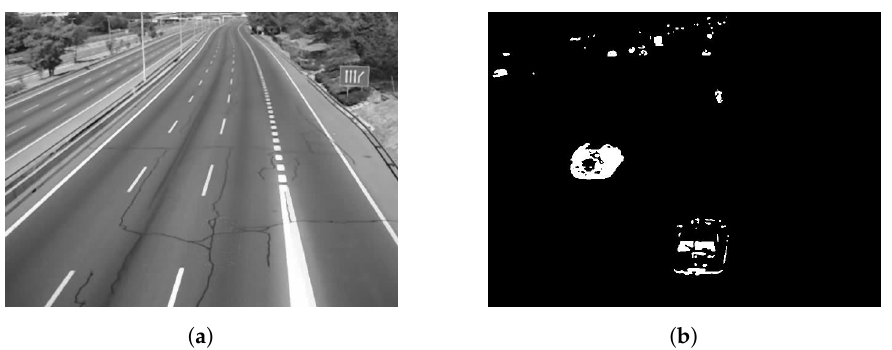
) and ( b ) gray mode ( I RGB 539